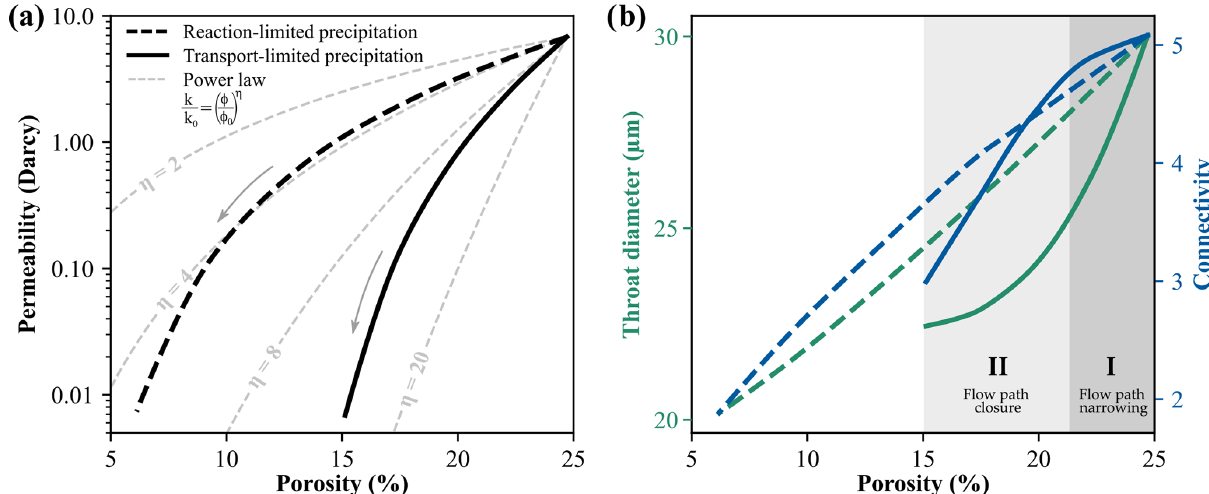
Figure 3. (a) Simulated porosity-permeability trends for reaction- and transport-limited precipitation regimes compared to analytical relations based on the power law with different exponents ( η ). (b) Evolution of median throat diameter and mean connectivity for both chemical regimes with the characteristic phases of (I) flow path narrowing and subsequent their complete clogging